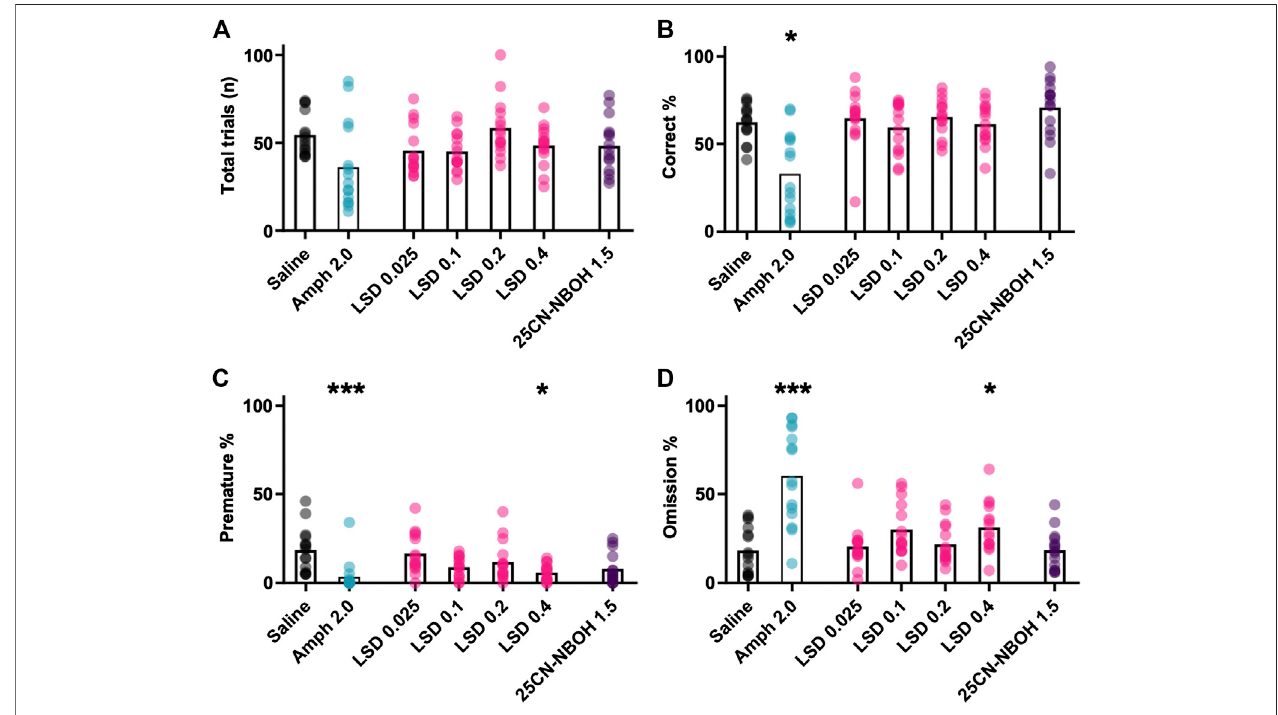
FIGURE 4 | Mean effects of different drug treatments on performance in the Iowa Gambling Task phase. The data show the mean and the individual values of the total number of initiated trials (A) , the percentage of correctly timed responses (Correct % (B) ), the percentage of prematurely timed responses (Premature % (C) ), and the percentage of completely omitted trials (Omission % (D) ). Statistically signi fi cant differences in comparison to saline shown as *** p < 0.001 and * p < 0.05.